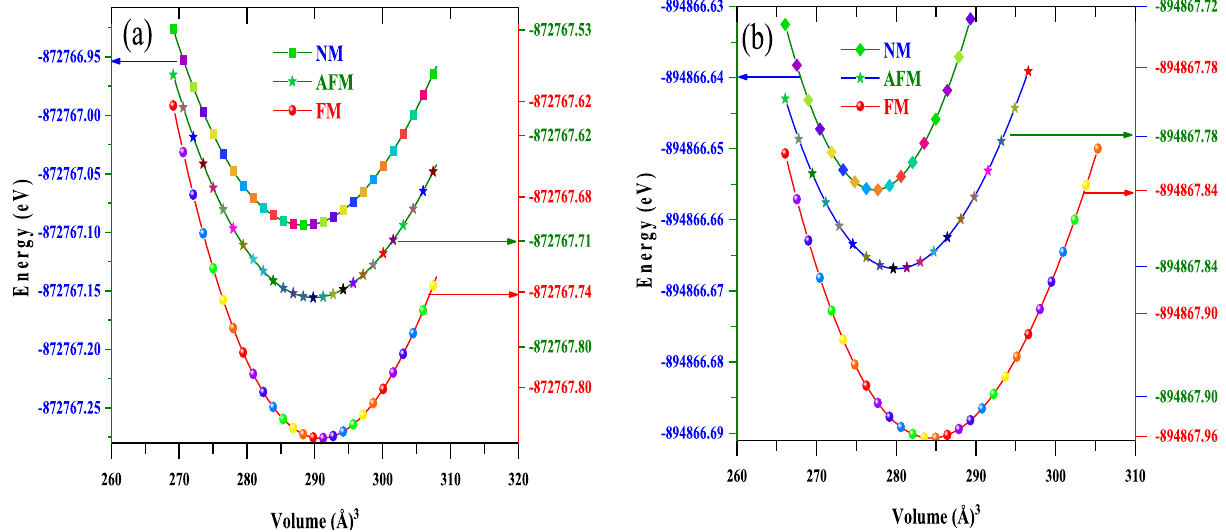
Figure 2. The optimised energy-volume plots for ( a ) RbNpO 3 and ( b ) RbPuO 3 oxides in three different magnetic phases (FM, AFM, NM), determined via the PBE-GGA